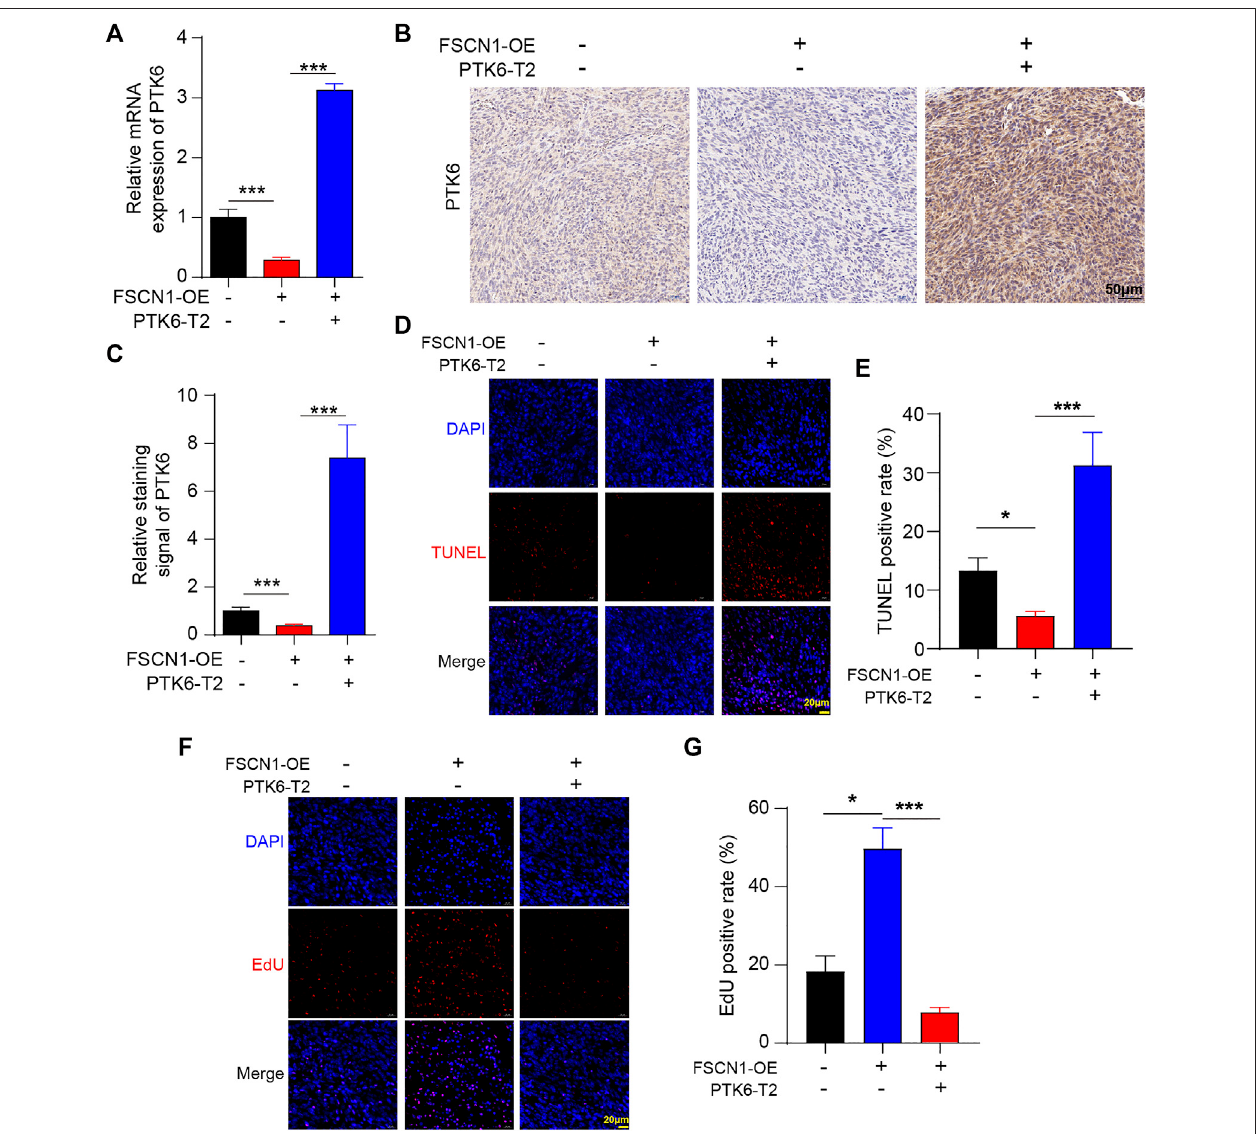
FIGURE7| PTK-T2inhibitsESCC tumor progression exvivo . (A) ThemRNAlevel ofPTK6intumor tissuesofNC,FSCN1-OE, andFSCN1-OE+PTK6-T2groups was detected. n = 5 per group, *** p < 0.001. (B) PTK6 in tumor tissues of NC, FSCN1-OE, and FSCN1-OE + PTK6-T2 groups was detected by immunohistochemical staining ( C ) Statistical analysis of B. n = 5 per group, *** p < 0.001. (D) TUNEL assay was performed in tumor tissues of NC, FSCN1-OE, and FSCN1-OE + PTK6-T2 groups. (E) Statistical analysis of D. n = 5 per group, * p < 0.05, *** p < 0.001. (F) EdU assay was performed in tumor tissues of NC, FSCN1-OE, and FSCN1-OE + PTK6-T2 groups. (G) Statistical analysis of F. n = 5 per group, * p < 0.05, *** p < 0.001.